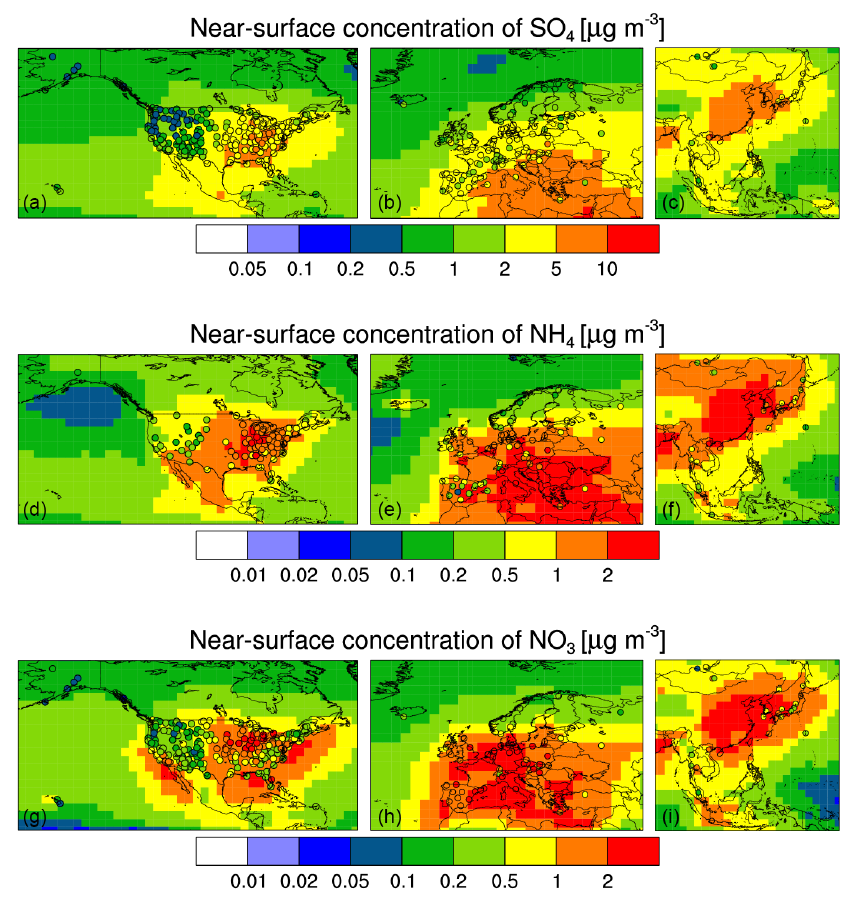
Figure 2. EMAC simulation with MADE3 (background color; “pixels” correspond to the model grid) vs. observations from station networks (filled circles): multi-year average near-surface secondary inorganic aerosol mass concentrations, i.e., SO 4 (a–c) , NH 4 (d–f) , and NO 3 (g–i) . The observational data in the three panels of each row are drawn from CASTNET and IMPROVE (a, d, g) , EMEP (b, e, h) , and EANET (c, f, i)